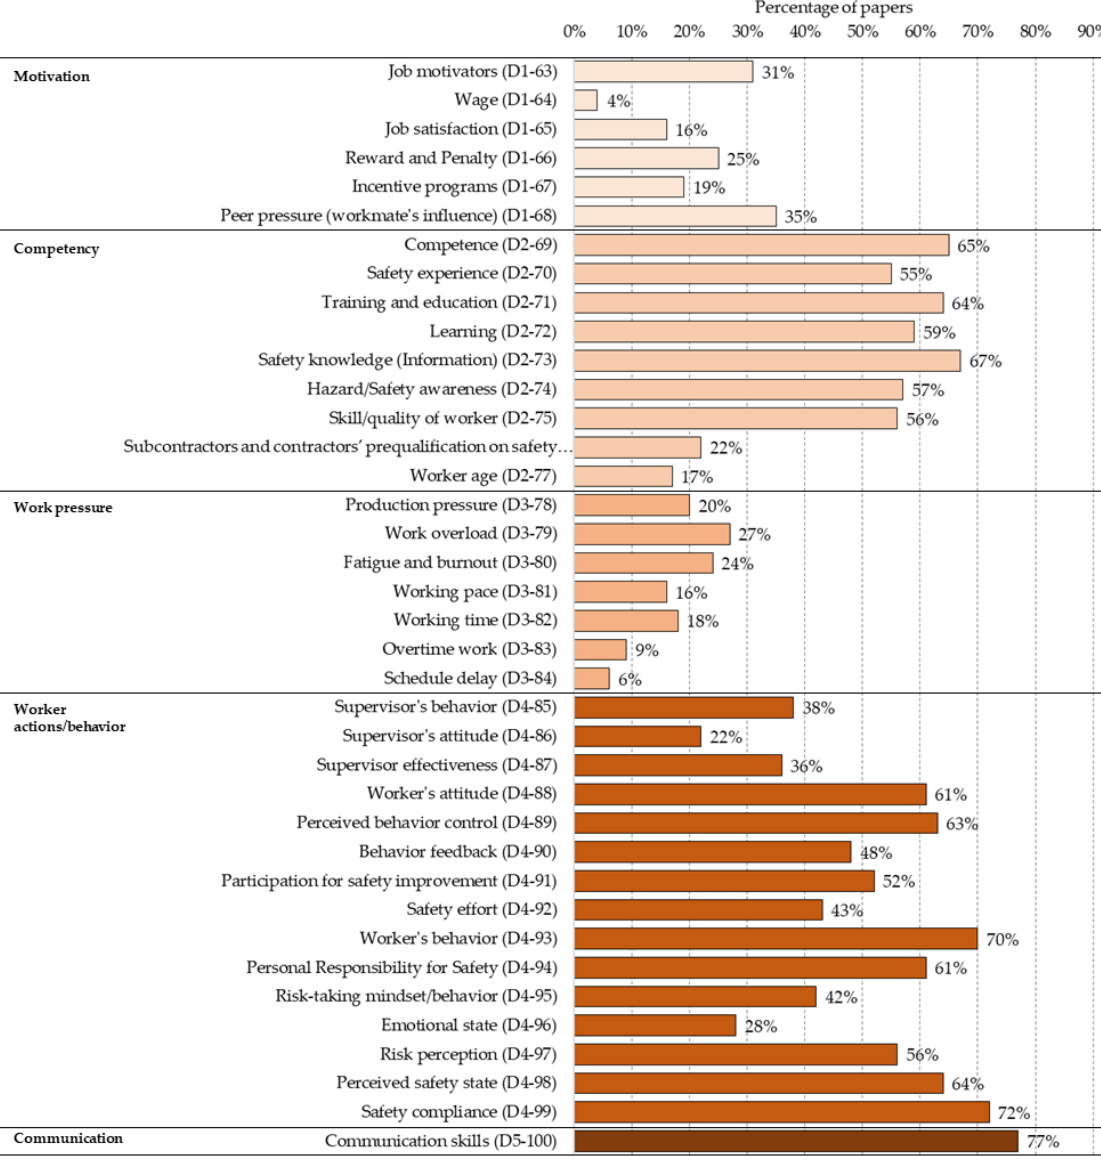
Figure 10. Percentage distribution of factors in the “Human aspects—worker and work team (D)” category.